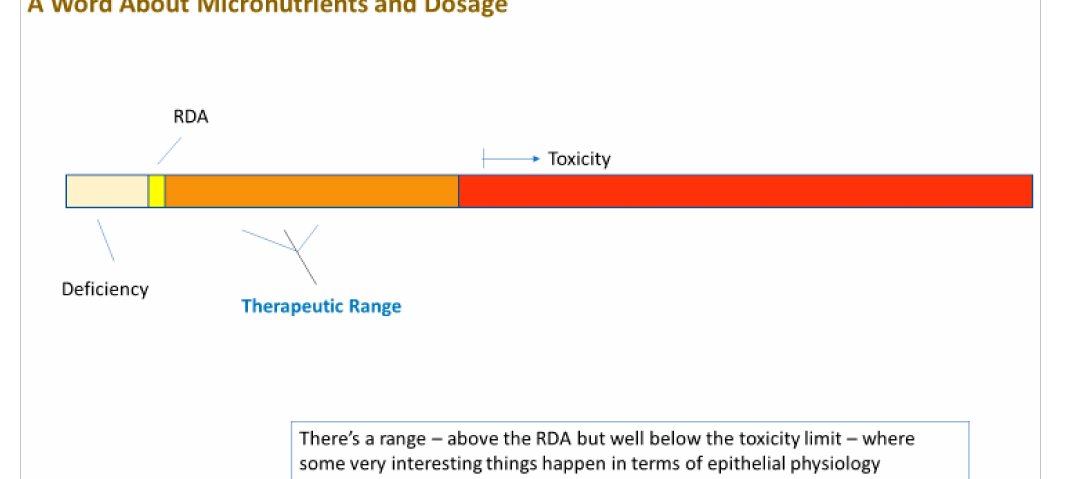
Figure 2. For many micronutrients, a therapeutic range can exist between the Recommended Daily Allowance (RDA) and concentrations/intakes that are toxic to the organism. In this range, activation of normally quiescent signaling pathways can occur, leading to beneficial physiological changes, among which is improved barrier